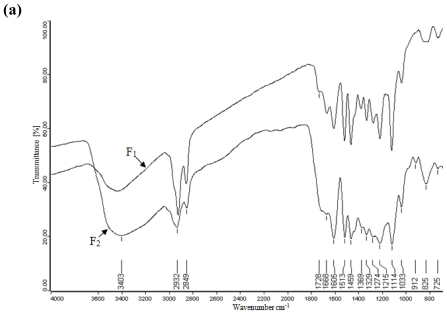
FT-IR spectra of lignin fractions (a) F1 and F2, (b) F3, F4 and F5.